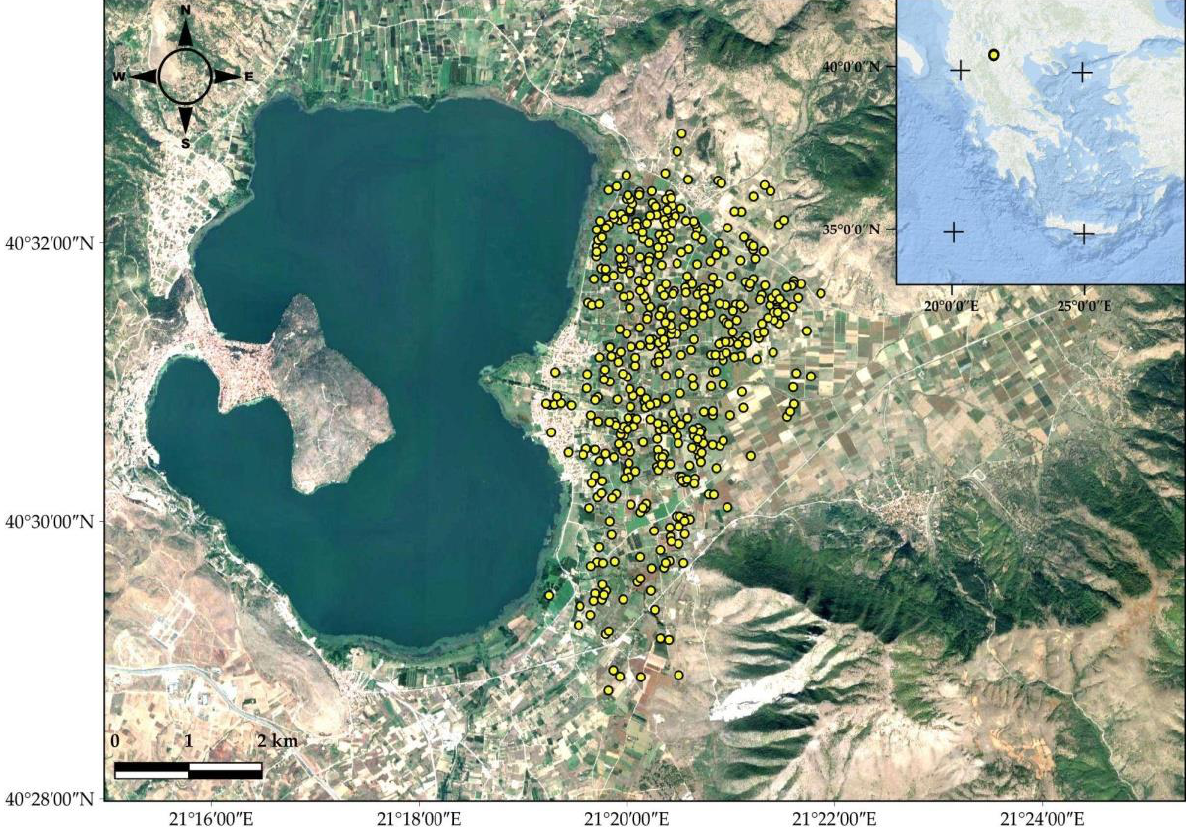
Figure 1. The study area on the shore of Lake Orestiada, in the regional unit of Kastoria, Greece. While the region of interest is flat, the mean altitude is around 640 m above sea level, ranging from 620 m near the lake to 700 m further north. The climate is temperate and often warm, with harsh winters that frequently keep the temperature below zero throughout the day. The average annual temperature is 11.5 ◦ C, with 636 mm of precipitation. Summers are hot and dry, with a relative humidity of 50% to 55%. Apple trees and beans are the primary agricultural